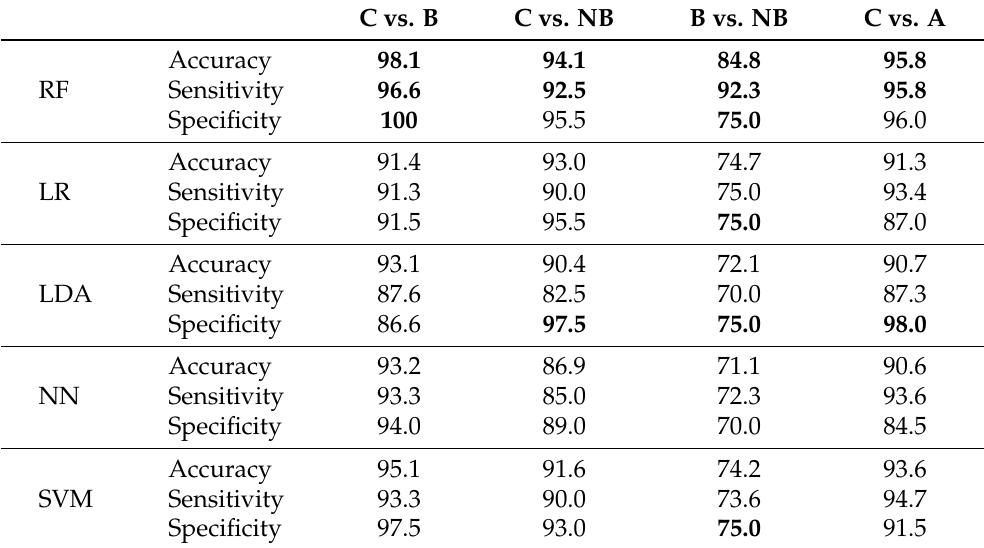
Table 5. Performance of female models. RF: Random Forest; LR: Logistic Regression; LDA: Linear Discriminant Analysis; NN: Neuronal Networks; SVM: Support Vector